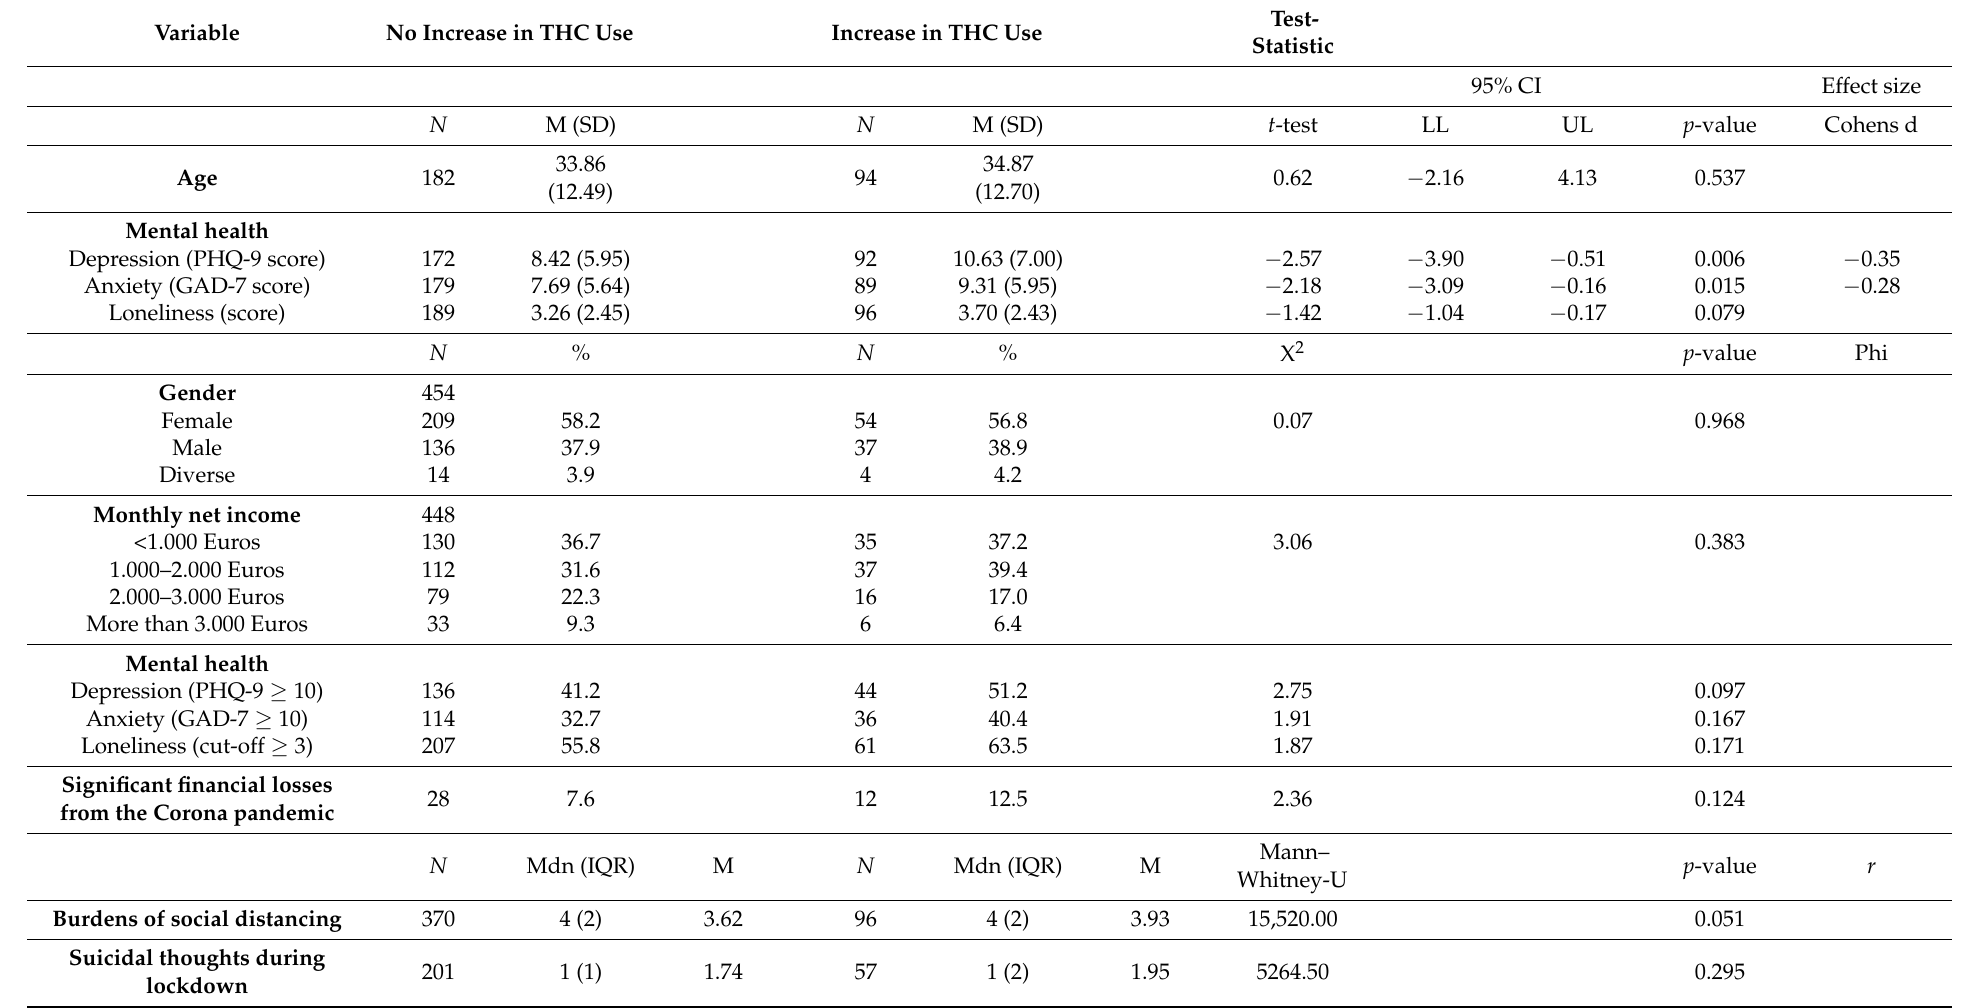
Table 8. THC consumption and mental